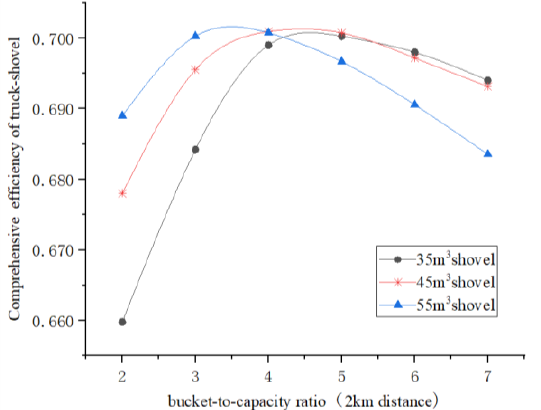
Figure 1. Relationship curves at 2 km transport distance.